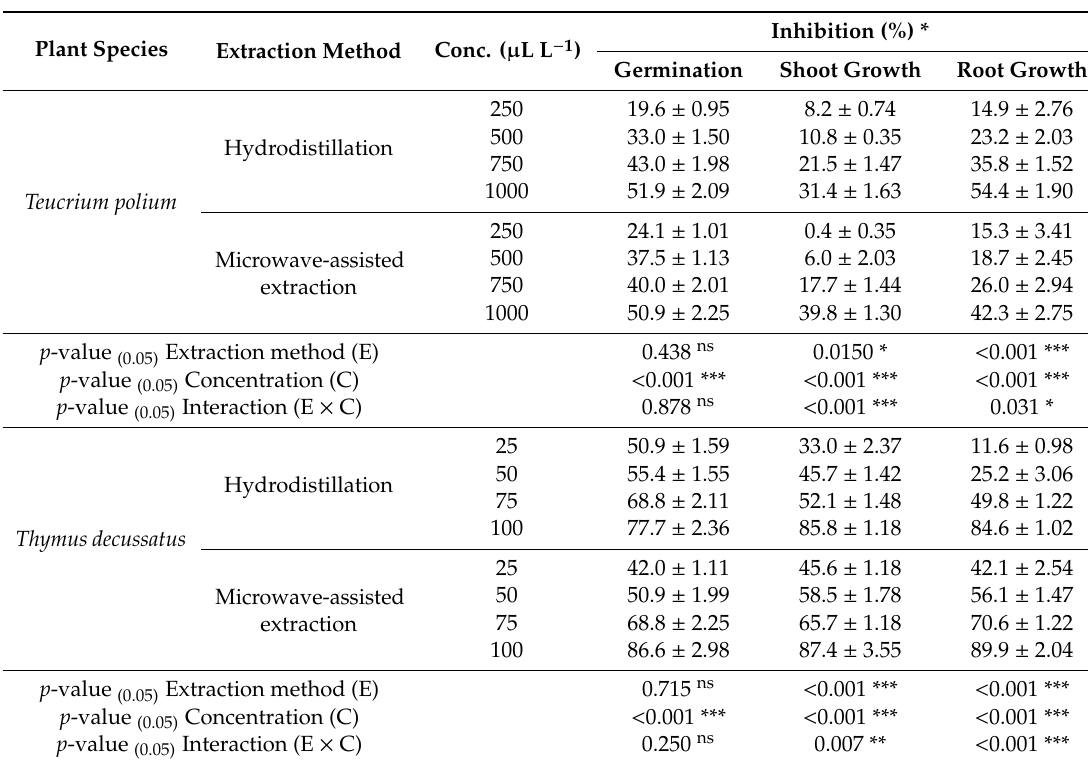
Table 2. Phytotoxic inhibitory activity of EOs extracted from Teucrium polium and Thymus decussatus using microwave-assisted extraction (MAE) and hydrodistillation (HD) methods.